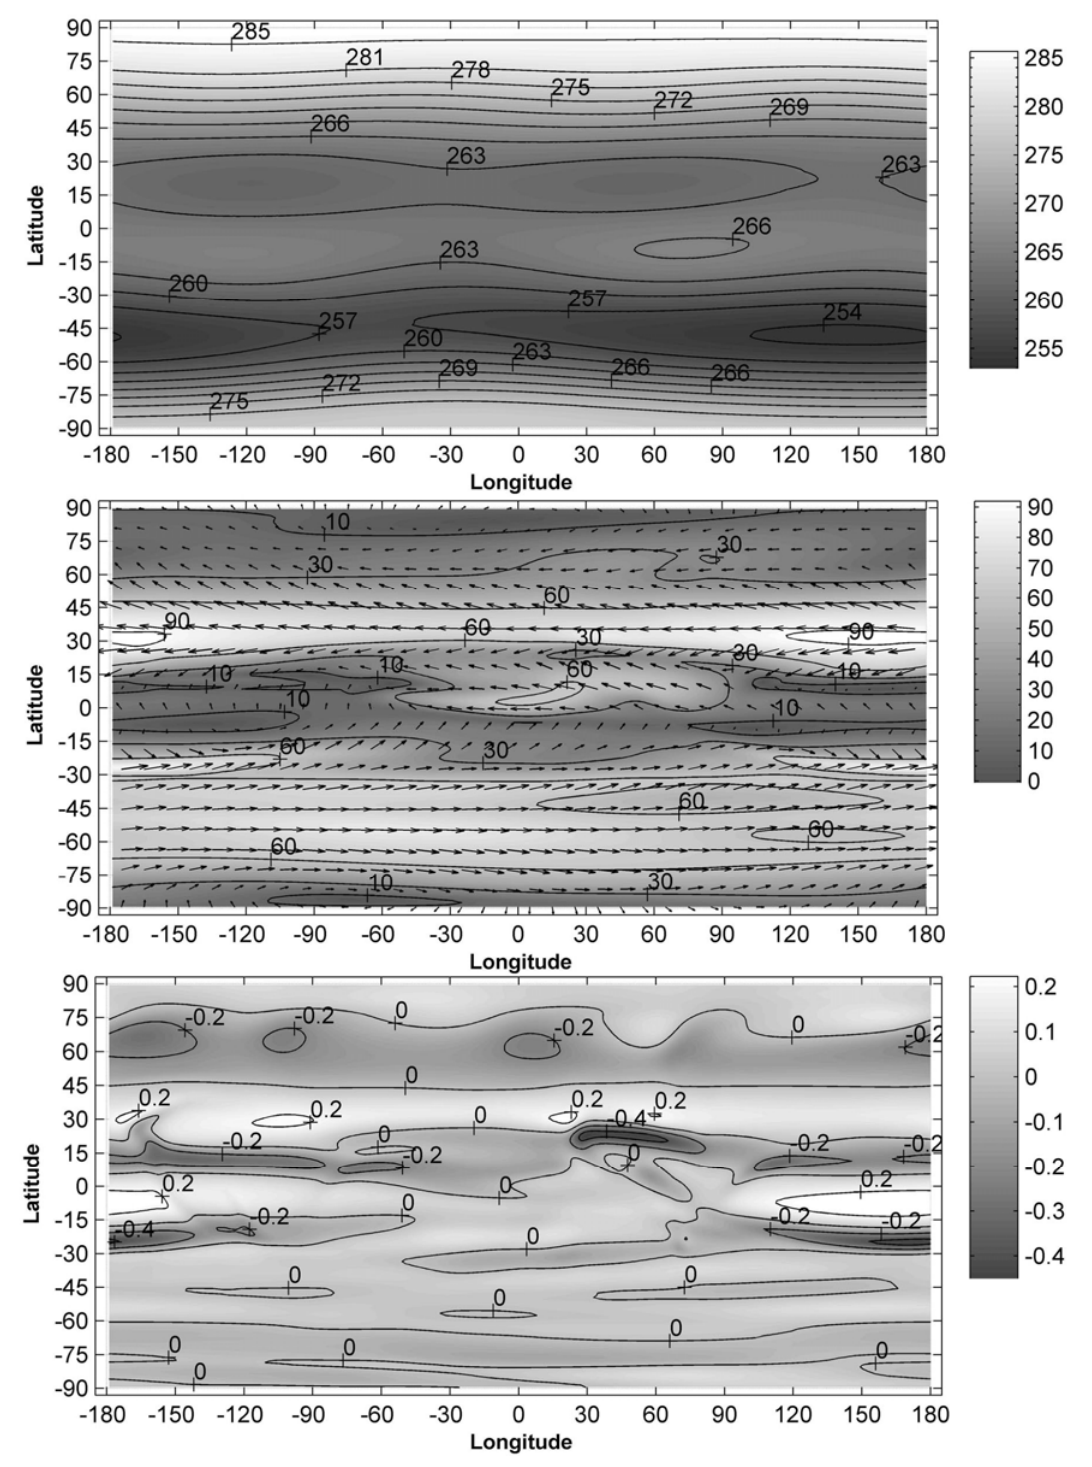
Figure 3. The same as in Figure 1 but obtained for 16